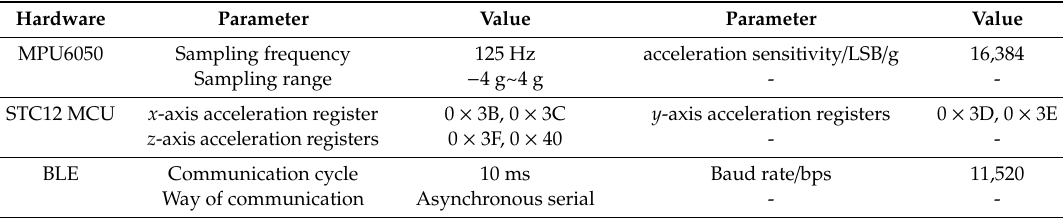
Table 1. Some important parameter settings of the hardware